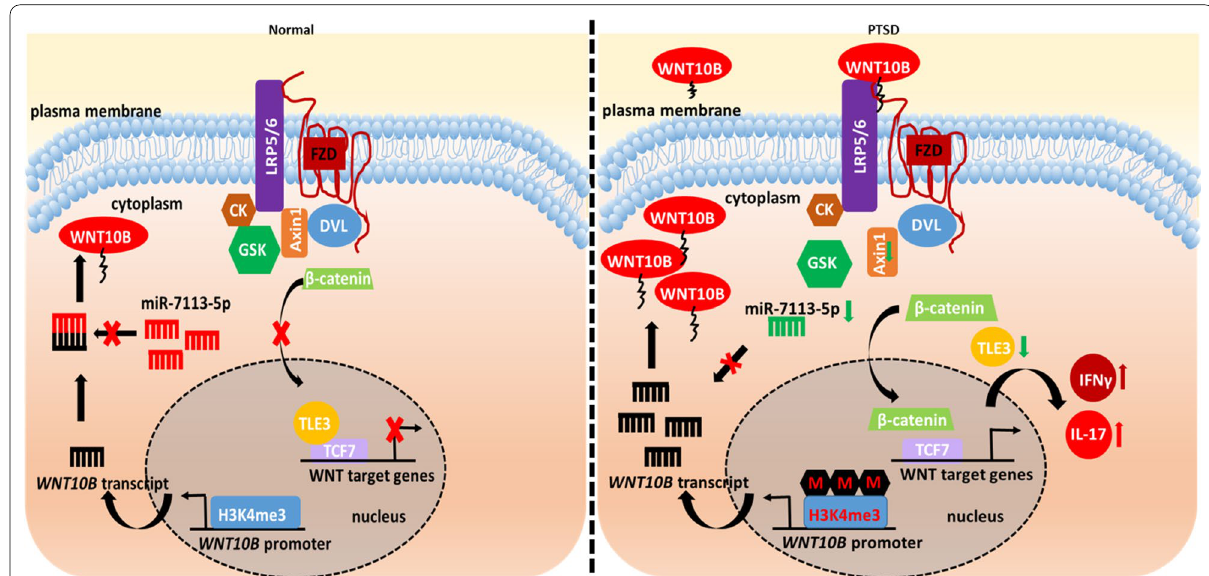
Fig. 6 Schematic showing our working hypothesis of WNT10B elevation leading to increased inflammatory gene expression because of histone modification and miRNA expression alteration in